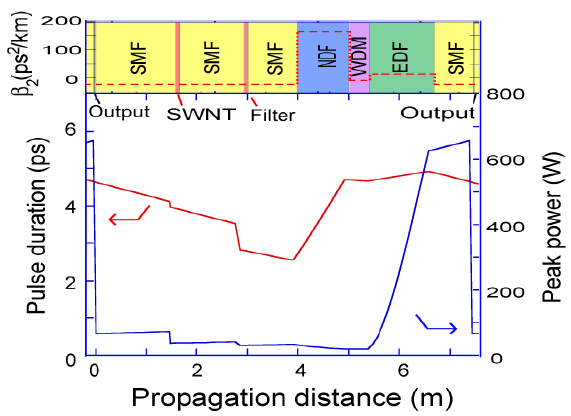
Figure 9. Dynamics of pulse propagation inside the fiber laser cavity for dissipative- soliton mode-locking